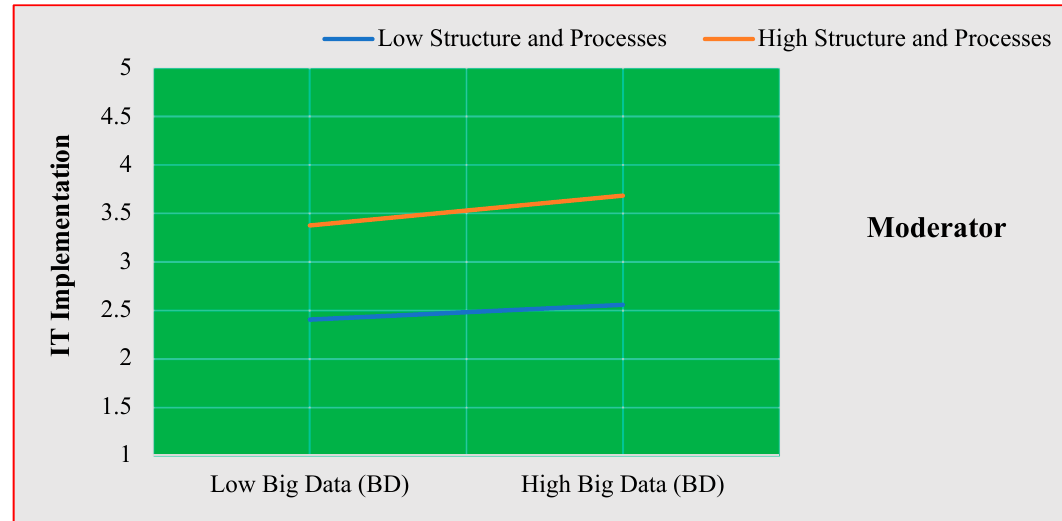
Figure 10. Moderation effect of structure and processes between big data (BD) and IT implementation which is strengthening the relationship.